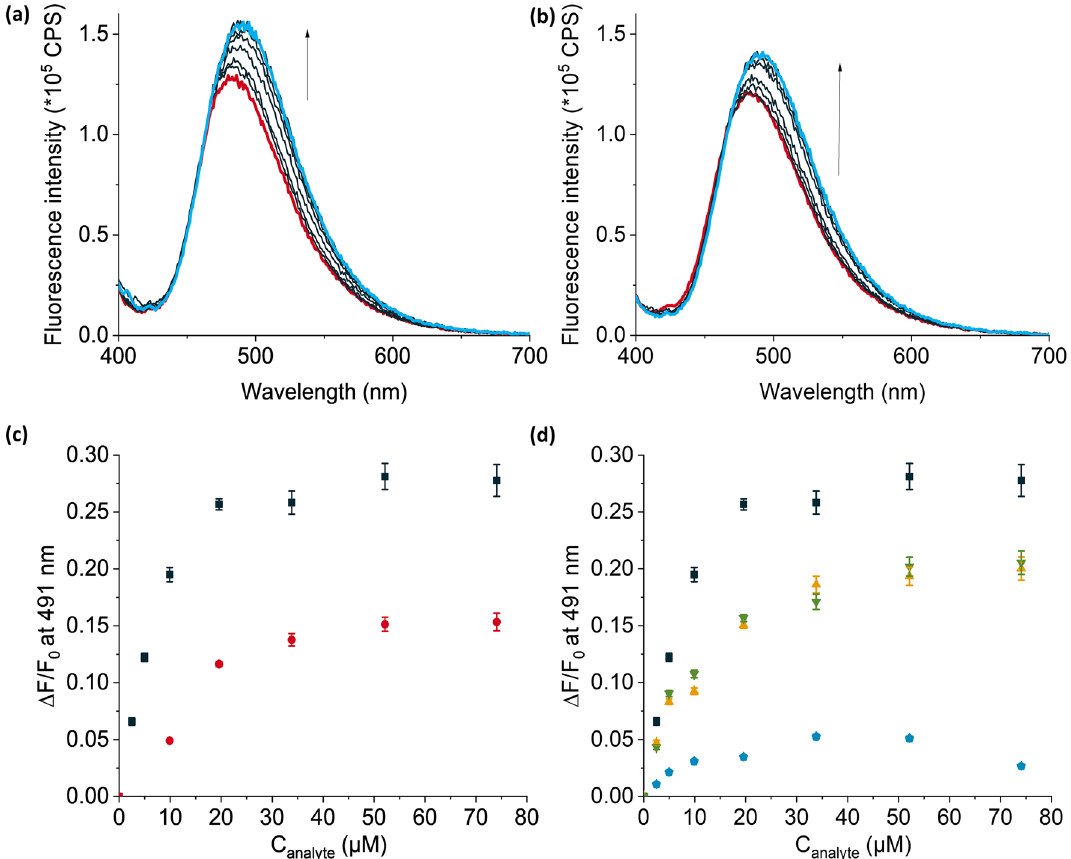
Figure 6. Fluorescence titration spectra of 2 mL each of 1 mg mL −1 suspensions of ( a ) MIPTHA@SiO 2 and ( b ) dNIPTHA@SiO 2 following addition of up to 74 µM of GPS-THA in chloroform. ( c ) Relative fluorescence (cid:31) F , at 491 nm after titration of MIPTHA@SiO changes, F 0 2 (black squares) and dNIPTHA@SiO 2 (red circles) (cid:31) F , after titration of MIPTHA@SiO with GPS-THA. ( d ) Relative fluorescence changes, F 0 2 with GPS-THA (black squares), MPPA-THA (blue pentagons), 2,4-D-THA (yellow triangles) and dicamba-THA (green up-side down triangles); for chemical structures of competitors, see Fig. 5. λ ex = 385